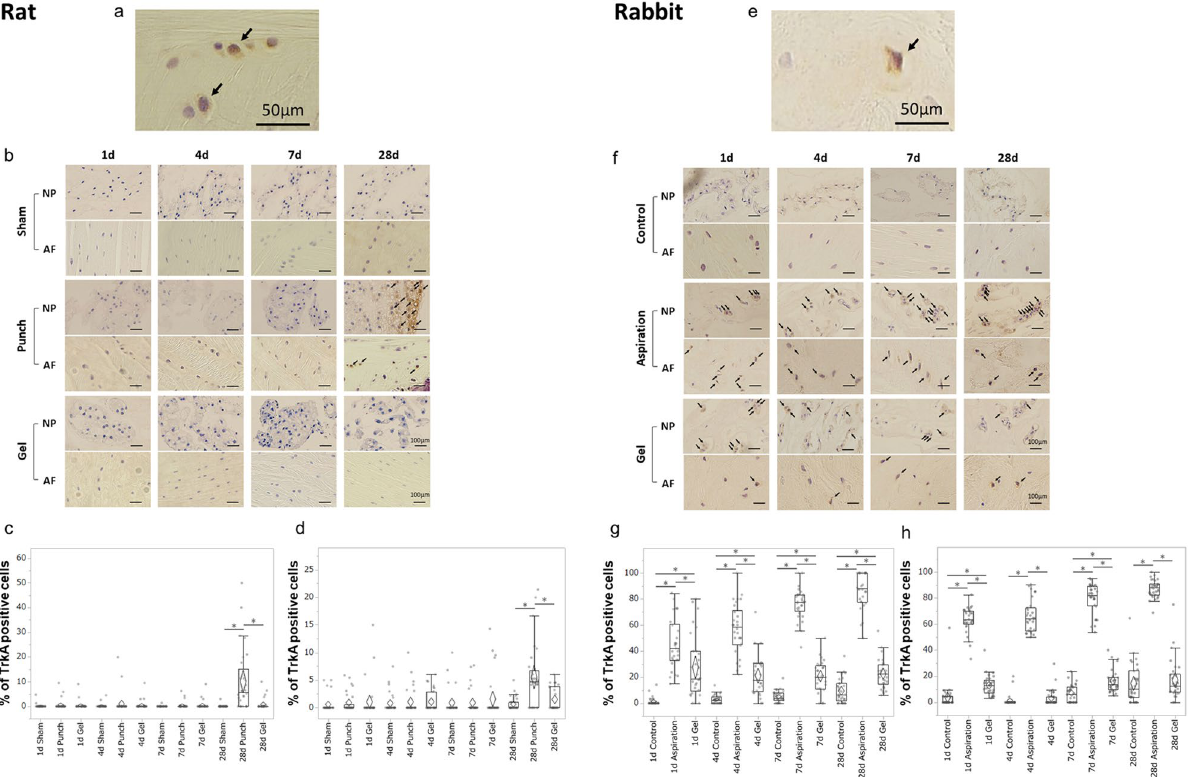
Figure 4. UPAL gel inhibits tyrosine kinase A (TrkA) receptor upregulation in rat and rabbit intervertebral disc (IVD) degeneration models. The rat nucleus pulposus (NP) punch ( a – d ) and rabbit NP aspiration ( e – h ) models were used for immunohistochemical (IHC) analysis to detect the TrkA levels 1, 4, 7, and 28 days after surgery. The number of TrkA-positive cells in each staining was calculated as a percentage of the number of total NP or annulus fibrosus (AF) cells. TrkA-positive cells are stained brown, and nuclei was stained purple. ( a ) Representative image of TrkA-positive NP cells in the rat model (allows). Scale bar, 50 µm. ( b ) Representative IHC staining for TrkA 1, 4, 7, and 28 days after surgery in rat NP and AF tissues. Arrows indicate IL-6- positive cells. Scale bar, 100 µm. Percentage of TrkA-positive cells in rat NP tissue ( c ) and AF tissue ( d ). ( e ) Representative image of TrkA-positive NP cells in the rabbit model (arrows). Scale bar, 50 µm. ( f ) Representative IHC staining for TrkA 1, 4, 7, and 28 days after surgery in the rabbit NP and AF tissues. Arrows indicate TrkA- positive cells. Scale bar, 100 µm. Percentage of TrkA positive cells in rabbit NP tissue ( g ) and AF tissue ( h ). There was a significant increase in the percentages of TrkA-positive NP and AF cells in the punch or aspiration group 28 days after surgery or at each time point, respectively (* P < 0.05). The boxes represent the median and the interquartile range, with the vertical lines showing the range. The rhombus shape represents the 95% confidence interval (at each time point, n = 3 rats; n = 6 IVDs in each